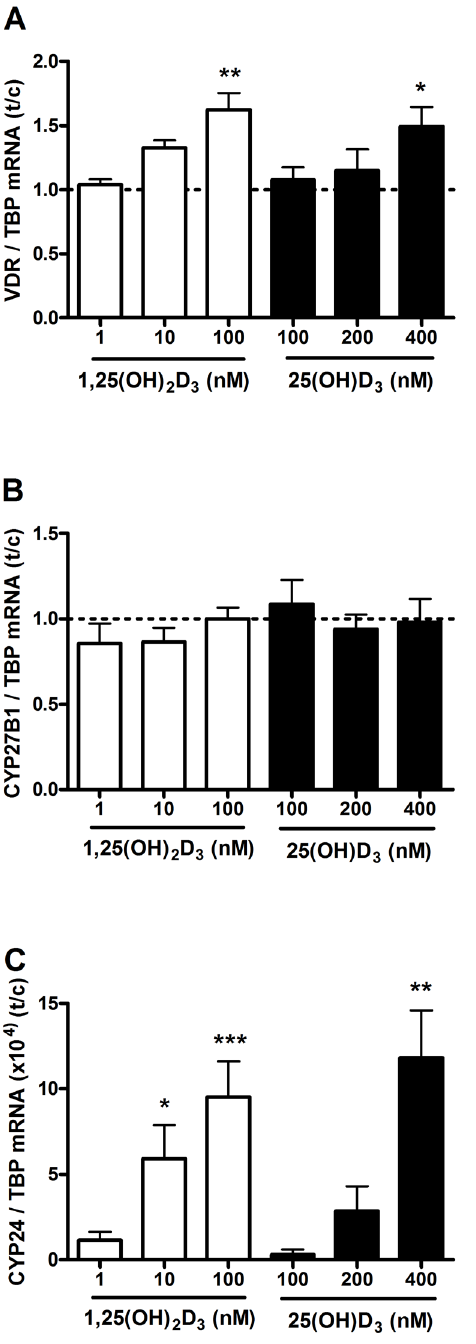
Figure 4. Effects of 1,25(OH) 2 D 3 and 25(OH)D 3 on VDR, CYP27B1 and CYP24 mRNA levels in primary human osteo- blast. Osteoblasts were cultured in the presence of 0, 1, 10 and 100 nM 1,25(OH) 2 D 3 or 0, 100, 200 and 400 nM 25(OH)D 3 for 24 hours and mRNA levels of VDR ( A ), CYP27B1 ( B ) and CYP24 ( C ) were determined. Results (mean 6 SEM) are expressed as treatment versus control ratios (control was set at 1.0; dashed line) using cells from 5 or 6 different donors. Results were analysed using Friedman test followed by Dunn’s post hoc test (*p , 0.05, **p , 0.01, ***p , 0.001).